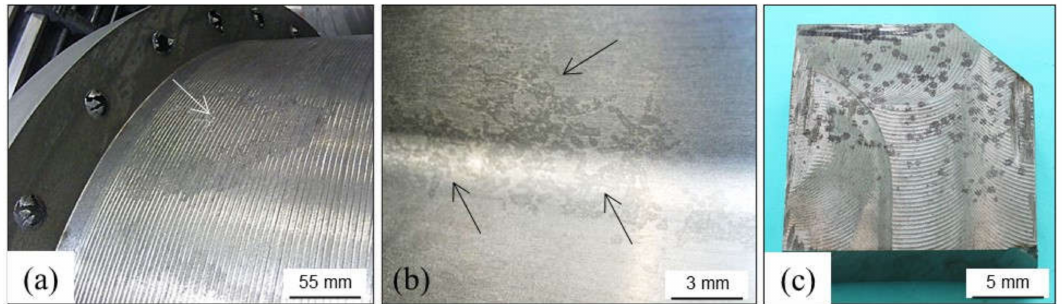
Figure 82. Dark shadows found in two heavy-section ductile iron castings after machining their surfaces ( a , b ). One affected sample showing a distribution of dispersed stains ( c